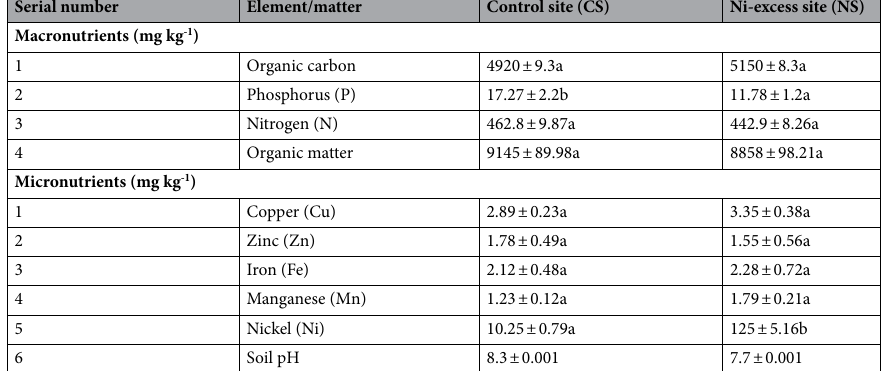
capacity of the bryophytes can be attributed to their higher surface-to-volume ratio and frequent absence of the cuticle 21 . HM-induced physiological responses and impacts on the phenological events of these tiny plants are